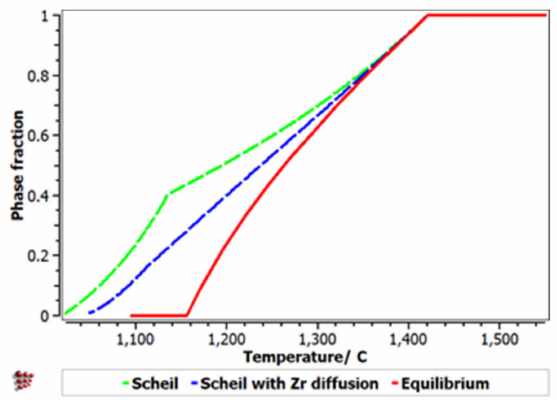
Figure 8. Scheil–Gulliver cooling diagram with Zr diffusion for the FeMnNb 0.5 TiZr 0.5 alloy. With the analysis of the equilibrium diagram, it can be observed that the high stability of the BCC–A2 phase determined a primary solidification at a temperature of 1420 ◦